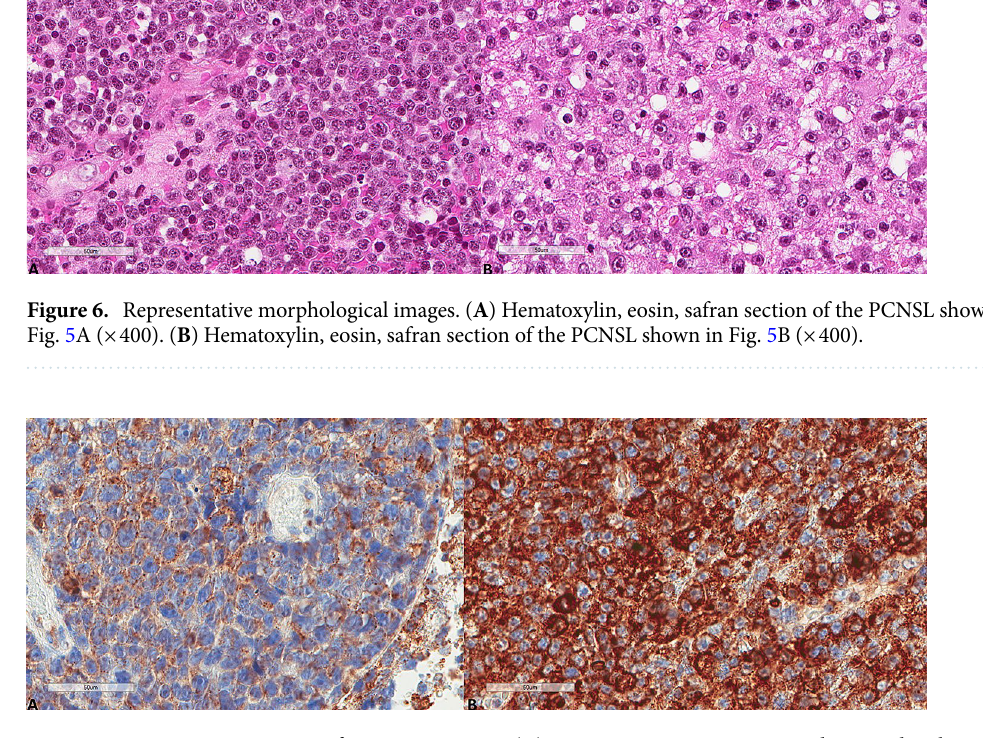
Figure 7. Representative images of M6PR expression. ( A ) Lower expression in a patient diagnosed with PCNSL MSKCC B group (× 400). ( B ) Higher expression in a patient diagnosed with PCNSL MSKCC C group (×